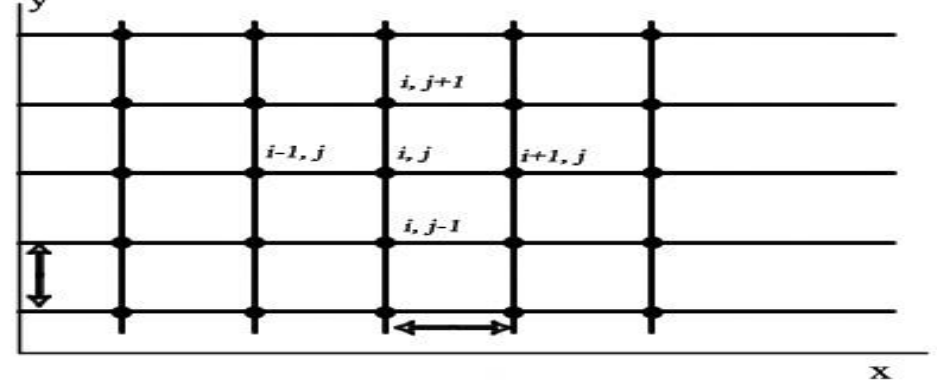
Fig. 6: An example of computational grid. direction. The results are shown Figs. (7 and 8).